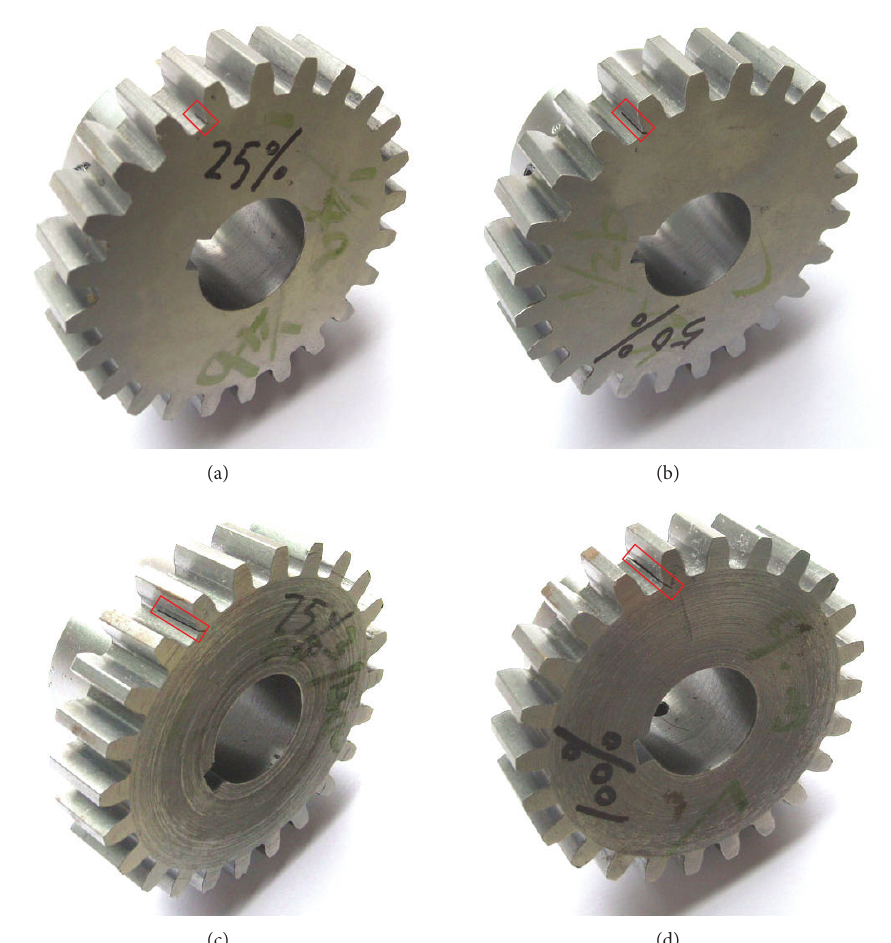
Figure 5: The different gear crack levels [24]: (a) crack level 25%; (b) crack level 50%; (c) crack level 75%; (d) crack level 100%.